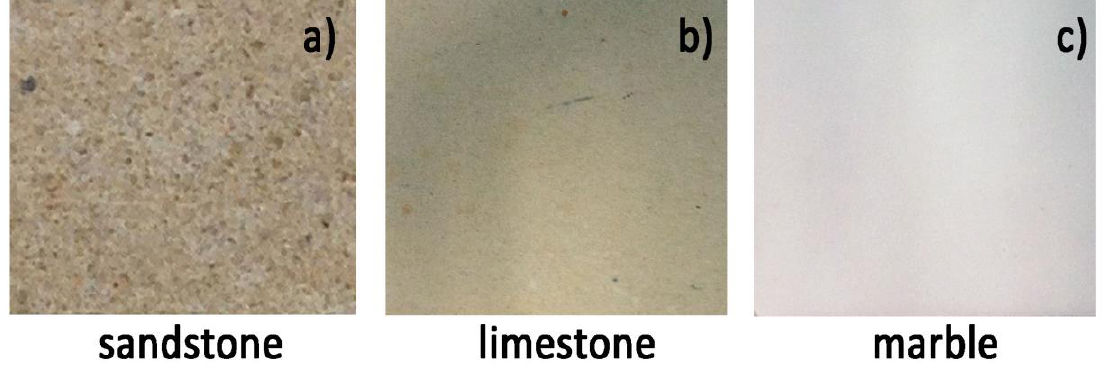
Figure 1. Substrates selected: ( a ) sandstone (Siena stone); ( b ) limestone (Lecce stone); ( c ) marble (Carrara marble).